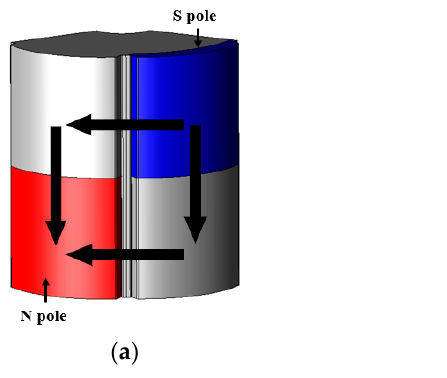
Figure 7. Magnetic flux direction and magnetic flux vector of intersect magnet consequent pole: ( a ) leakage magnetic flux direction, ( b ) magnetic flux vector.